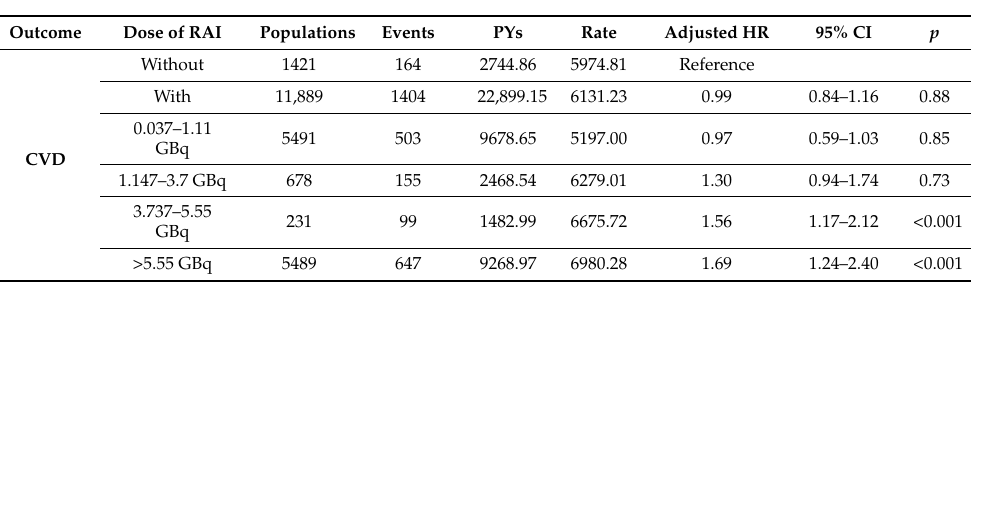
Table 3. Factors of CVD and CVD-specific mortality among different dosages of RAI using Cox